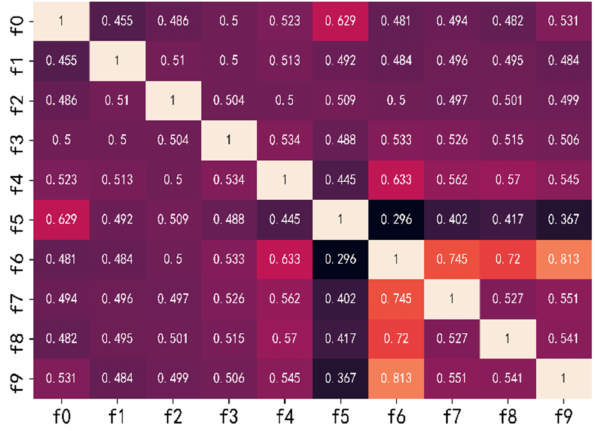
Figure 4. Thermodynamic diagram of residential sample data.